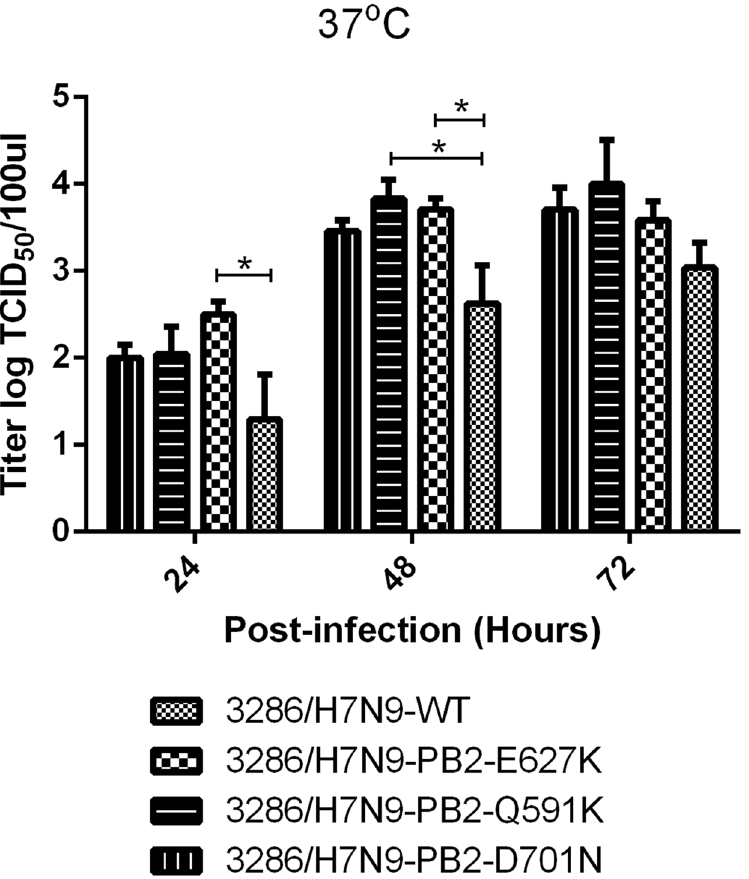
Figure 2. Replication kinetics of the duck 3286/H7N9 variants on A549 cells. A549 cells were infected with the indicated viruses at an MOI of 0.01 and cultured at 37 °C in the presence of TPCK-trypsin at 0.2 ug/ml respectively. Culture supernatants were harvested at the indicated times and virus titers were determined by TCID 50 assay. Results are the average of three independent experiments. The viral titers in PB2 mutants were compared to the recombinant wild type virus using the two tailed, non-paired t-test. * p <